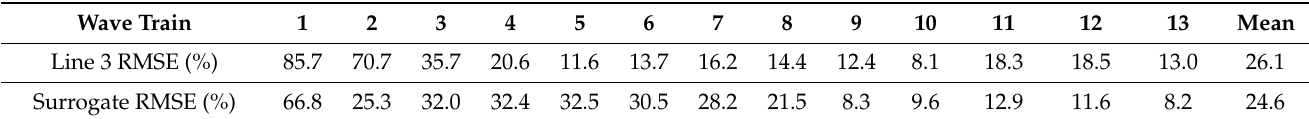
Table 5. Mean root mean square error (RMSE) of measured and MOJS approximated force peaks of total force in x-direction for Line 3 and surrogate for all wave trains.